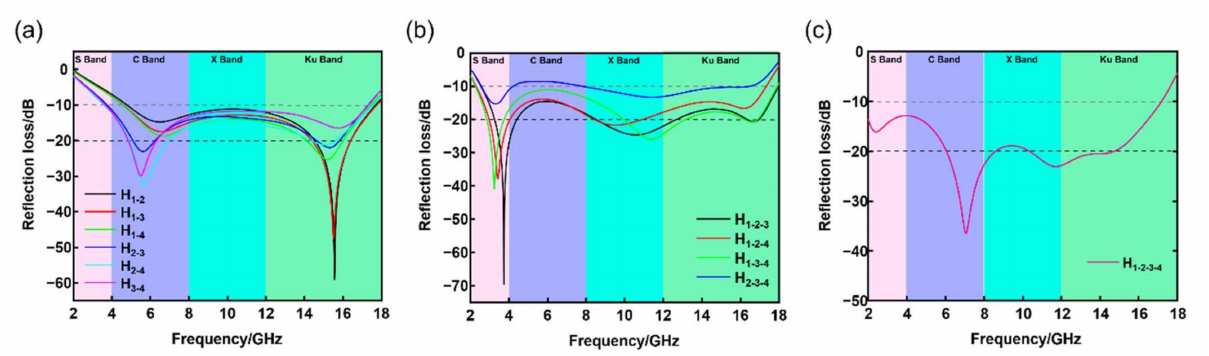
Figure 8. Reflection loss of multi-layer HC composites. ( a ) Double-layer, ( b ) triple-layer, ( c )